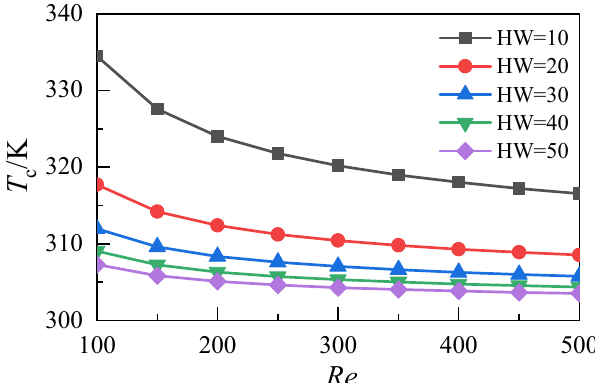
Figure 13. Temperature distributions of fluid-solid surface in microchannels with different aspect ratios.